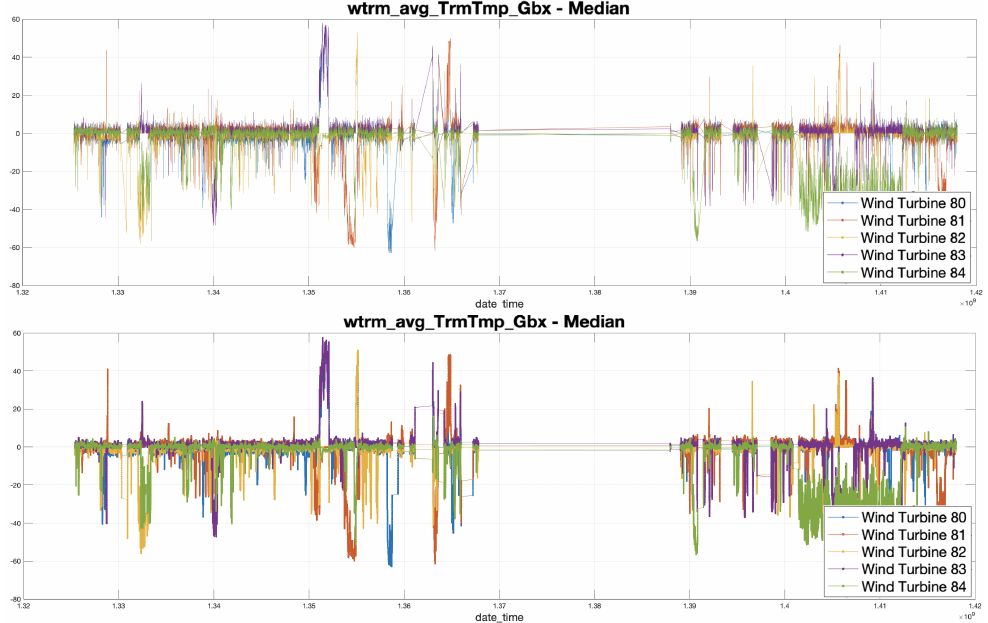
Figure 11. At the top, an overlaid representation of the residues obtained from the signal wtrm_avg_TrmTmp_Gbx corresponding to each of the analysed turbines (WT80–WT84) for the tem- poral intervals in which the SCADA system has been operating. At the bottom, the same signals smoothed by a 50-sample moving average filter.